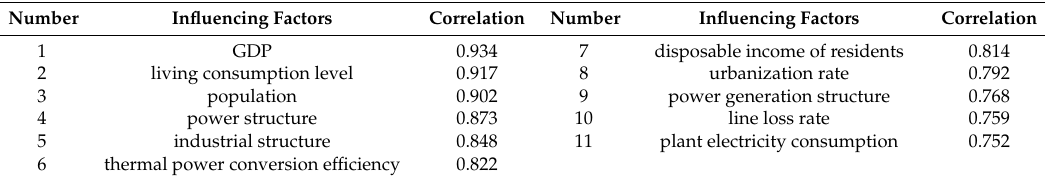
Table 1. Correlation analysis of 11 influencing